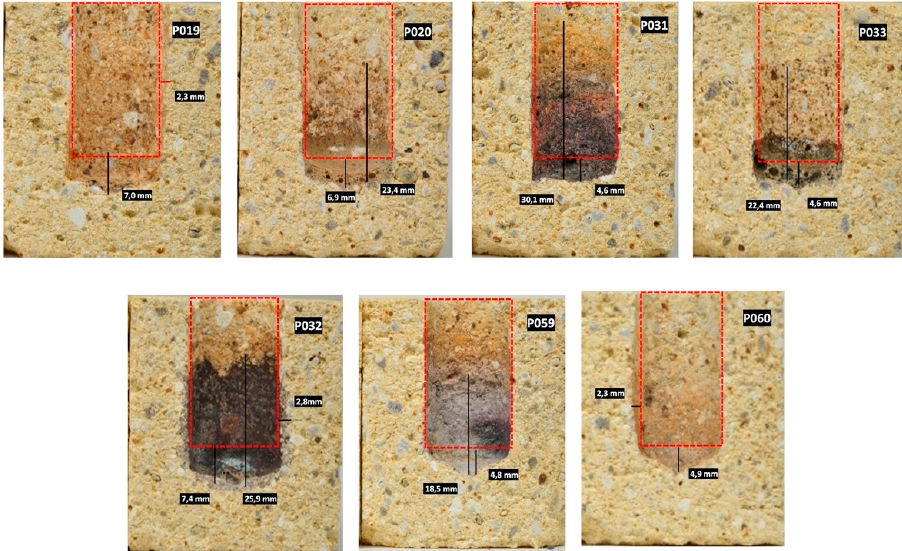
Figure 9. Corrosion of STV refractory materials using different types of wood ash and defined parameters of crucible test: 2.9 g ash/2 h/1200 °C.